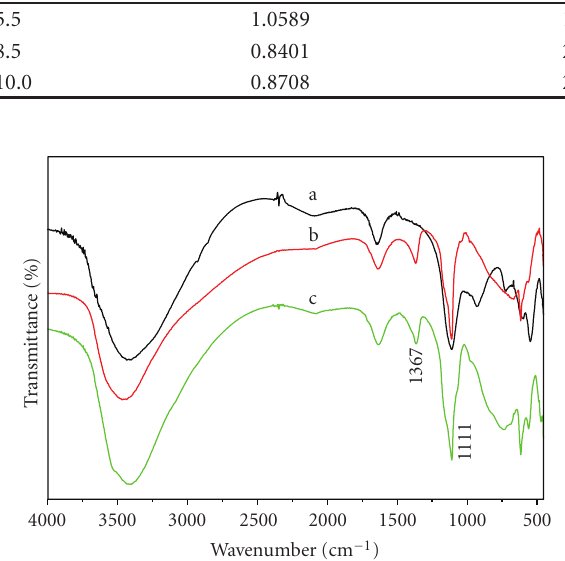
Figure 1: IR spectra of Ni/Al LDHs prepared at di ff erent pH values a: 5.5; b: 8.5; c: 10.0.